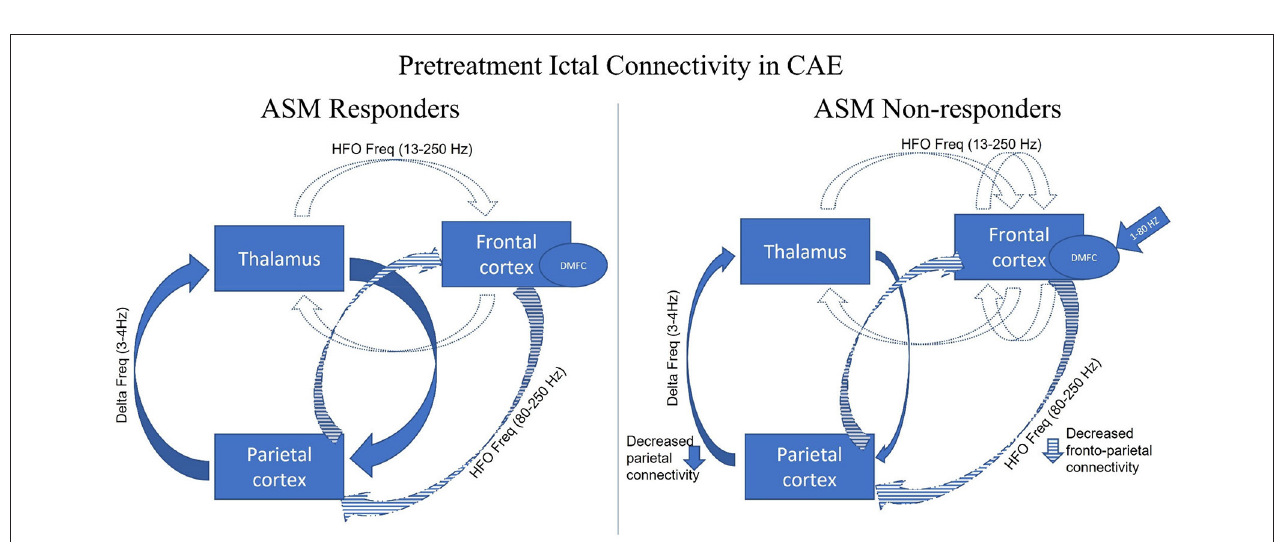
FIGURE 3 | Adapted with permission from Tenney et al. (47). Figure showing pretreatment ictal connectivity analysis of the antiepileptic (ASM) (ethosuximide, lamotrigine, and valproic acid) responder and non-responder in CAE. The three major brain regions have been identified as responsible for the generalization of the childhood absence seizures (thalamus, frontal cortex, parietal cortex). Given all the findings collected from Tenny et al. (47), Miao et al. (128), and Zhang et al. (129), parietal cortico-thalamic network at the low frequencies (blue solid) and a co-occurring frontal corticothalamic network at higher frequency (blue dotted) and anterior-posterior/frontoparietal network at higher frequency (blue stripped). Compared to the responder, ASM non–responders have ictal neuromagnetic sources at 1–80Hz localized to the dorsomedial frontal cortex (DMFC) (blue arrow). In addition, the ASM non–responders have decreased parietal cortico-thalamic at 3–4Hz and frontoparietal network connectivity at 80–250Hz with increased frontal local connectivity at 13–250Hz.